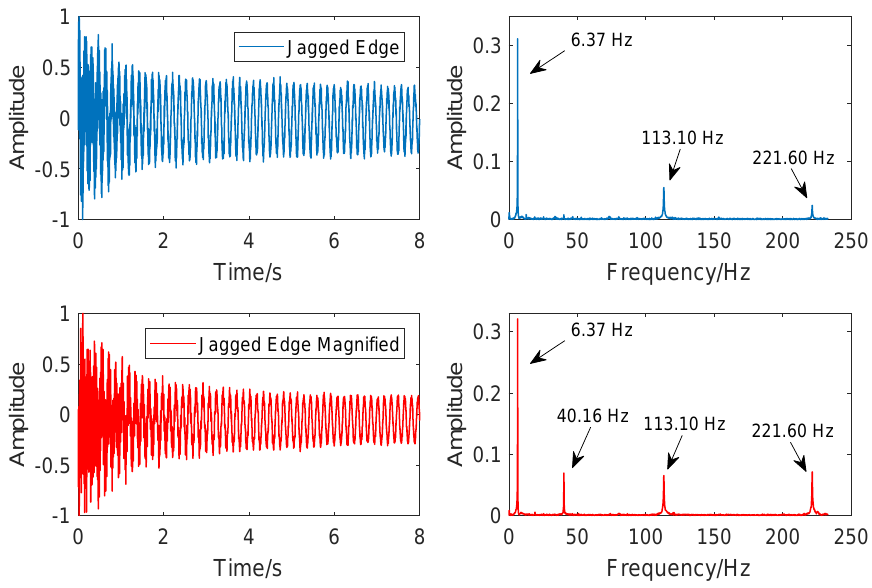
Figure 7. Vibration signals and their frequency spectrums extracted from the original video (blue line) and the magnified video (red line) along the jagged edge of the saw blade.